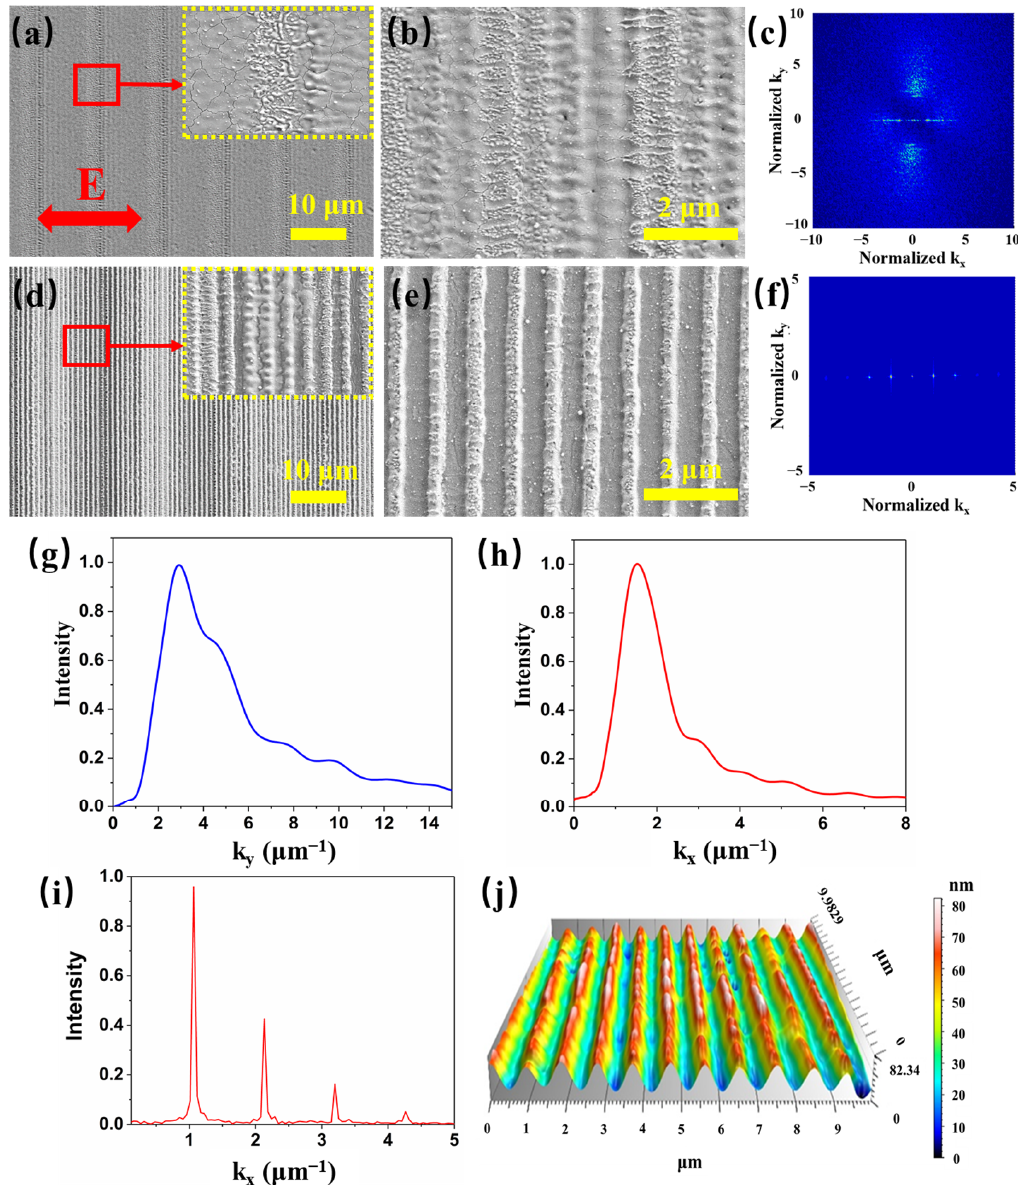
Figure 3. SEM images of micro/nanostructures on the ITO film after laser irradiation for scanning velocity of ( a ) 12, ( b ) 6, ( d ) 4 and ( e ) 3 mm/s with pulse fluence fixed at 0.66 J/cm 2 . The scale bars are 10 µm in ( a ) and ( d ) and 2 µm in ( b ) and ( e ). The insets in ( a ) and ( d ) are the enlarged SEM images for the red square areas. ( c ) and ( f ) are the 2D Fourier transform (FT) images of the LSFL in ( b ) and ( e ), respectively. ( g ) and ( h ) are the corresponding FT spectrums for k x = 0 µm −1 and k y = 0 µm −1 in ( c ), respectively. ( i ) is the corresponding FT spectrum for k y = 0 µm −1 in ( f ). ( j ) is the confocal optical microscope image of ( e ).